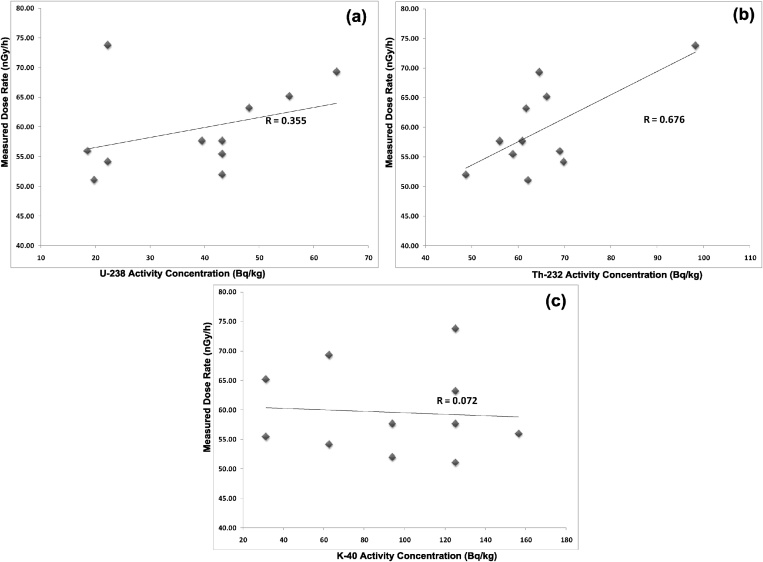
Correlation plots between (a) 238U and DR (b) 232Th and DR (c) 40K and DR.